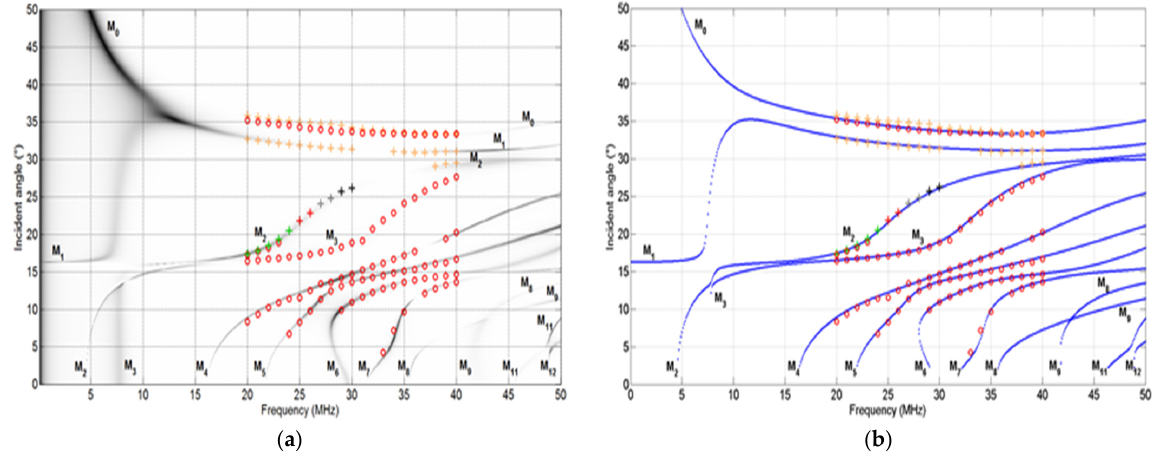
Figure 8. ( a ) Superimposition of all the mode velocities, generated and detected with the classical V(z) transducer (circles) and the segmented one (crosses), with the modulus of the reflection coefficient; ( b ) corresponding superimposition with the dispersion curves.